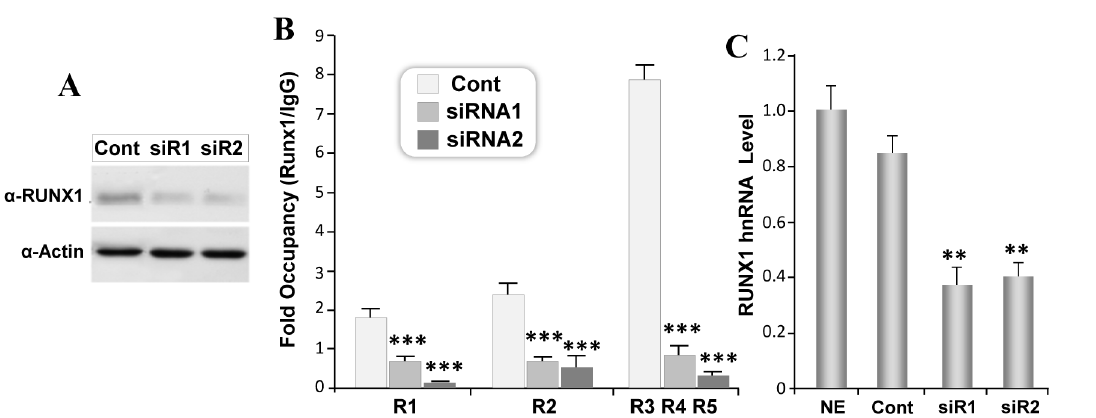
Fig 5. Depletion of endogenous RUNX1 protein in hematopoietic cells decreases occupancy and activity of RUNX1 P1 promoter. A) Jurkat cells were electroporated with 80nM of either control siRNA (Cont) or two different siRNA directed against RUNX1 (siR1 and siR2). Cells were harvested 48h later and equal amount of proteins were resolved by SDS PAGE. Blots were probed with polyclonal antibody against RUNX1, stripped and re-probed with polyclonal antibody against Actin. A representative image of chemiluminescence signal is shown. B) Jurkat cells were electroporated with indicated siRNA for 48h and processed for chromatin immunoprecipitation. Equal amount of immunoprecipitated DNA was subjected to real time PCR amplification. Data was averaged from three independent experiments and is presented as fold over IgG for respective RUNX motifs. C) Jurkat cells electroporated with control or RUNX1 siRNA were pelleted 48h later to isolate RNA. Level of P1 promoter derived RUNX1 hnRNA was determined by qPCR using primer pair located in exon 1 and intron 1. Pooled data from three independent experiments with three replicate each is shown for non electroporeted (NE) and siRNA electroporated Jurkat cells. Asterisks indicate statistically significant decrease in expression of RUNX1 hnRNA ( ** p < 0.01, *** p < 0.001).